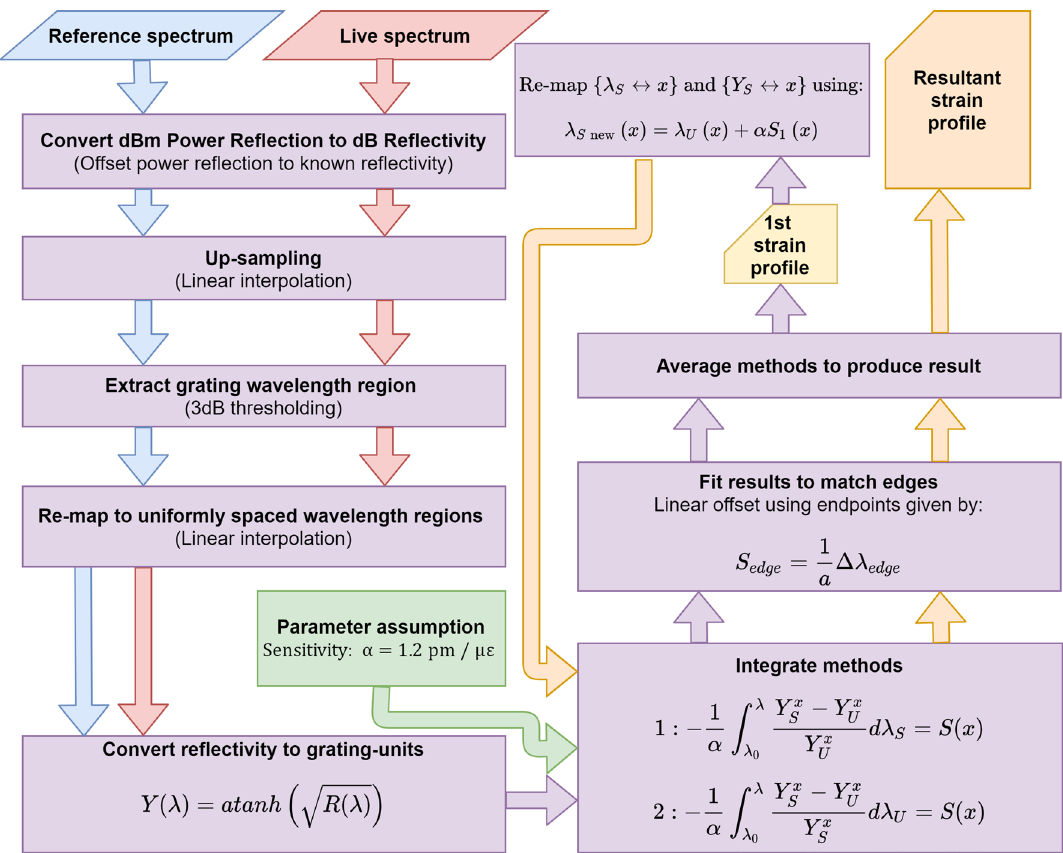
Figure 1. A flowchart of the process involved in measuring strain/temperature profile from a